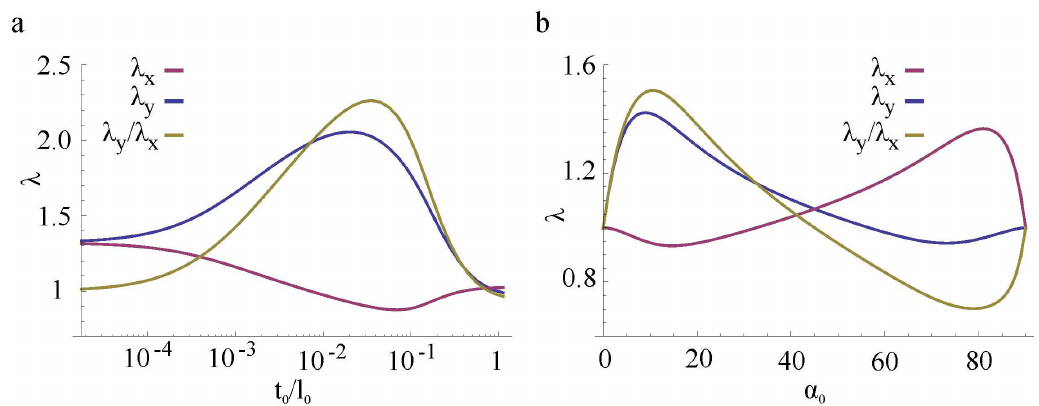
Fig 5. Influence of walls aspect ratio (t 0 /l 0 ) and honeycomb angle ( α 0 ) on the honeycomb swelling deformations for G W = G MW4 = 176.7 MPa and G I = G MI = 0.135. (a) Influence of walls aspect ratio on the honeycomb expansion.For walls of vanishingthickness the honeycombexpands isotropically as the inclusions. For very thick walls the honeycomb doesn‘t expand at all. (b) Influenceof honeycombangle on the honeycomb